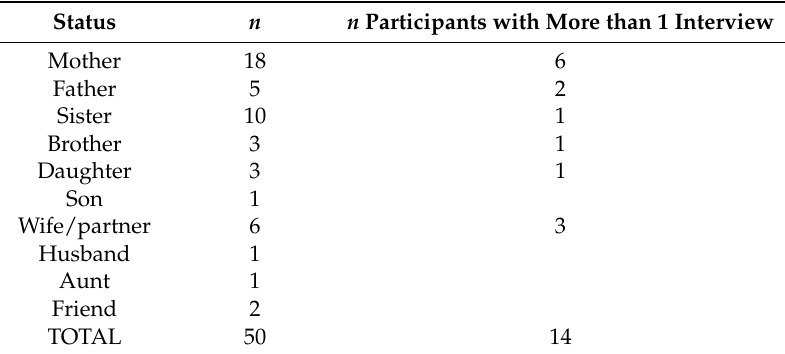
Table 1. Characteristics of the interviewees by